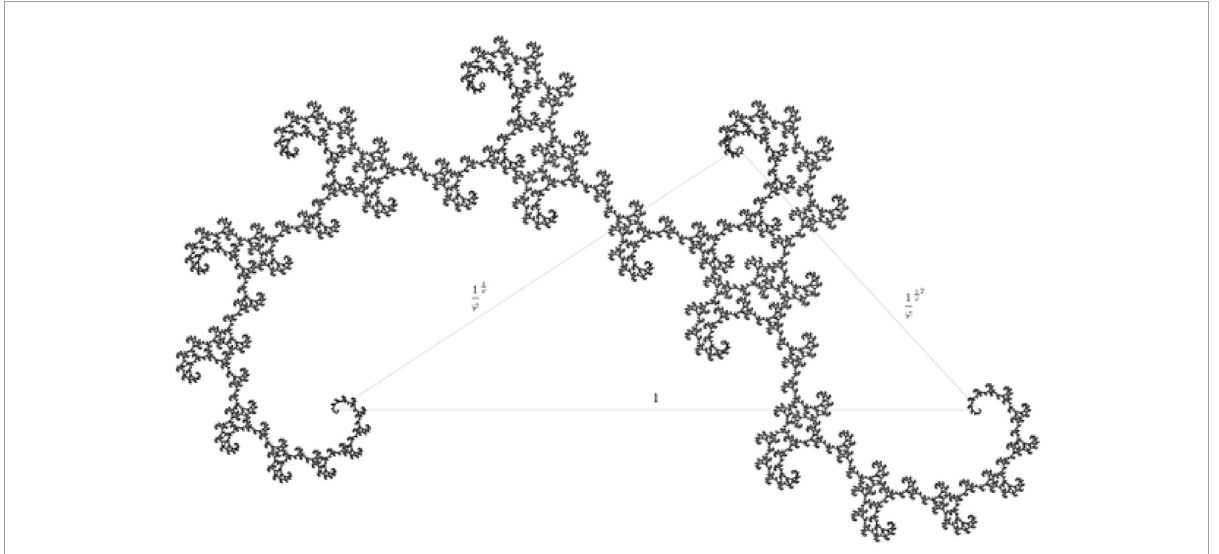
FIGURE 5 This numerically calculated fractal pattern is called a golden dragon and has a Hausdorff dimension of D A = 1 . 61803. (https://en.wikipedia.org/ wiki/List_of_fractals_by_Hausdorff_dimension). Note the similarity with dataset #8 in Figure 4 .